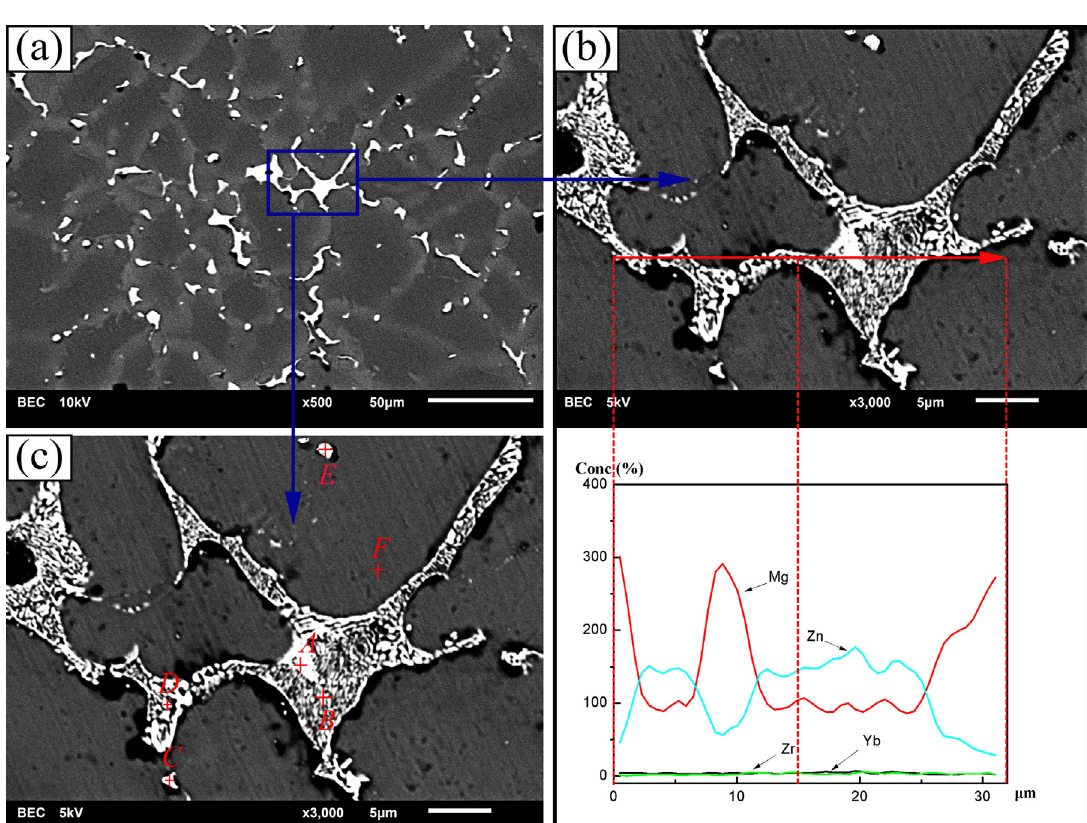
Figure 2. (a) SEM image of the phase constitution in the as-cast structure, (b) concentration profile of the composition across the coarse phase and (c) high magnification image of the selected area in (a), measured by